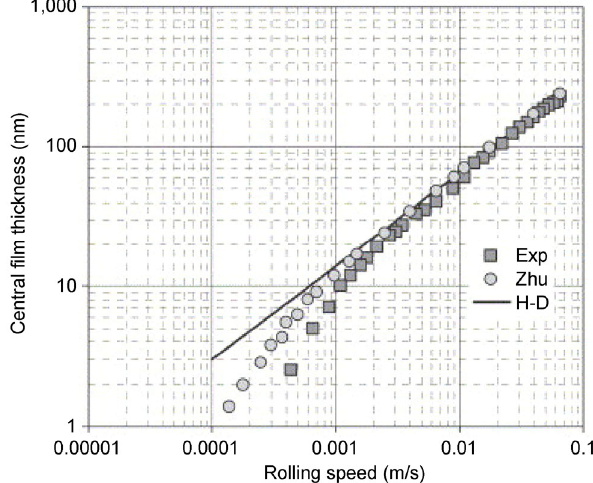
Fig. 11 Film thickness values of hexadecane obtained at maximum Hertz pressure of 2.942 GPa reported by Krupka et al.